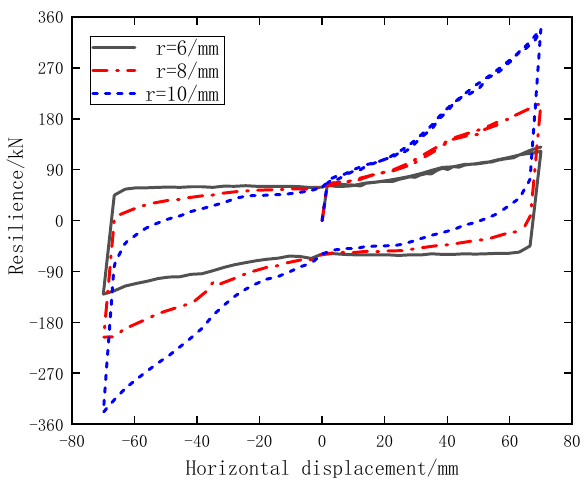
Figure 14. Hysteresis curves of SMA-negative stiffness hyperboloid shock absorber with different SMA numbers.